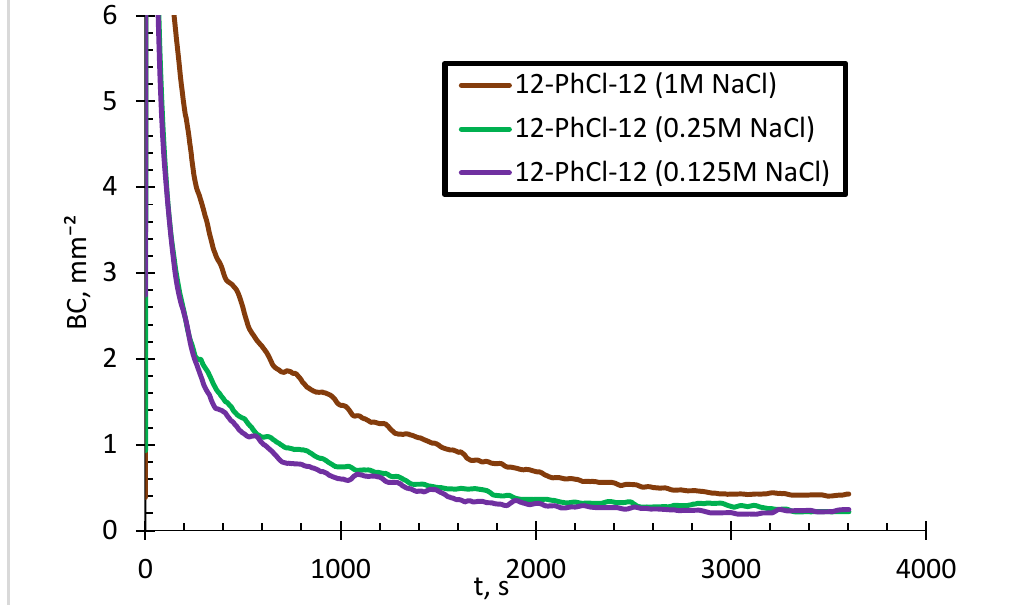
Figure 9. Effect of salinity on bubble count of the foam generated using 12-PhCl-12. Figure 9. E ff ect of salinity on bubble count of the foam generated using